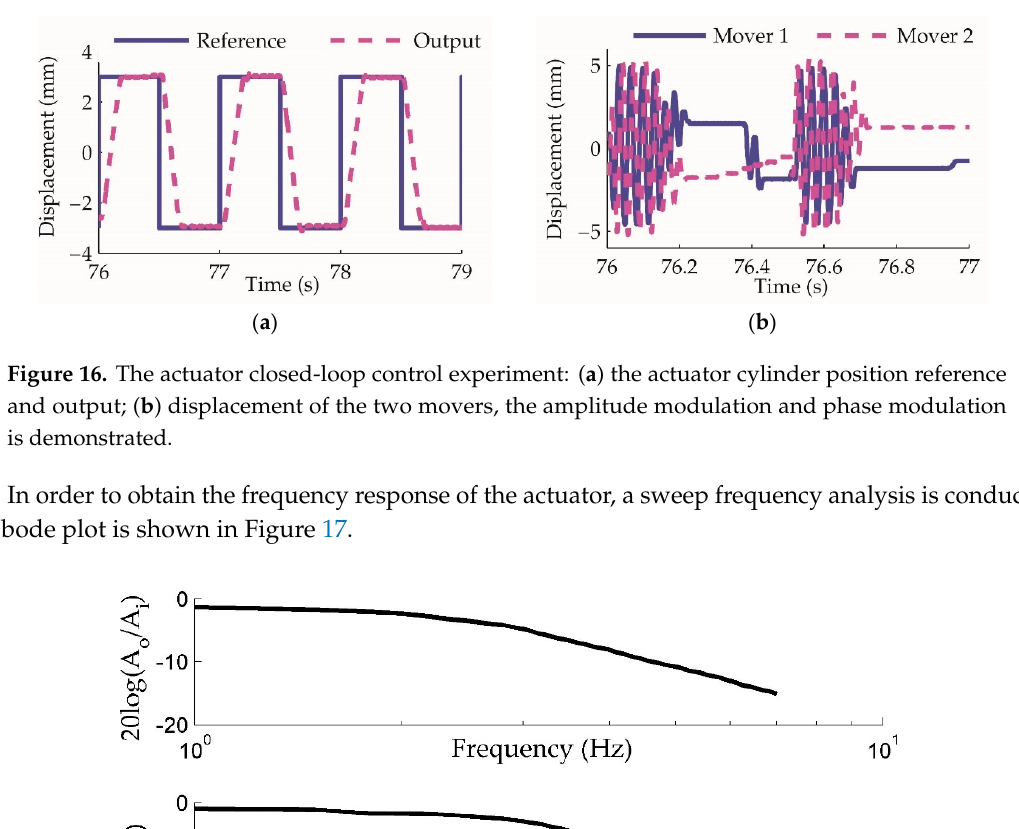
Figure 17. The frequency response of the closed-loop actuator.